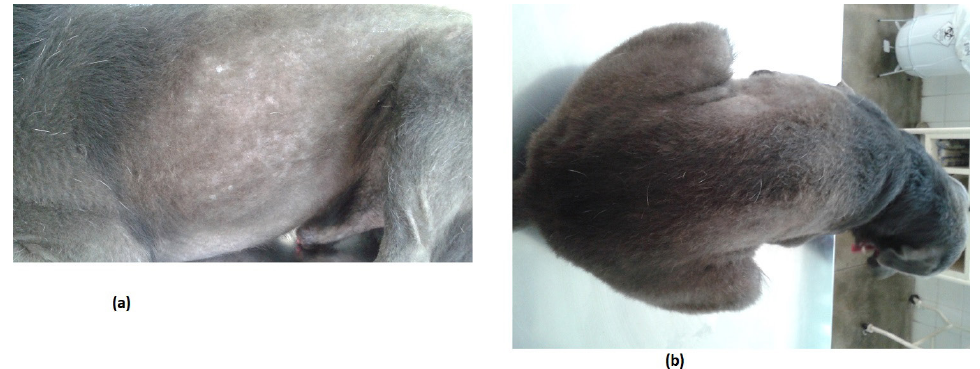
Figura 4. Canino SRD diagnosticado com Alopecia por Diluição da Cor apresentando areas de hipotricose após dois meses de tratamento na